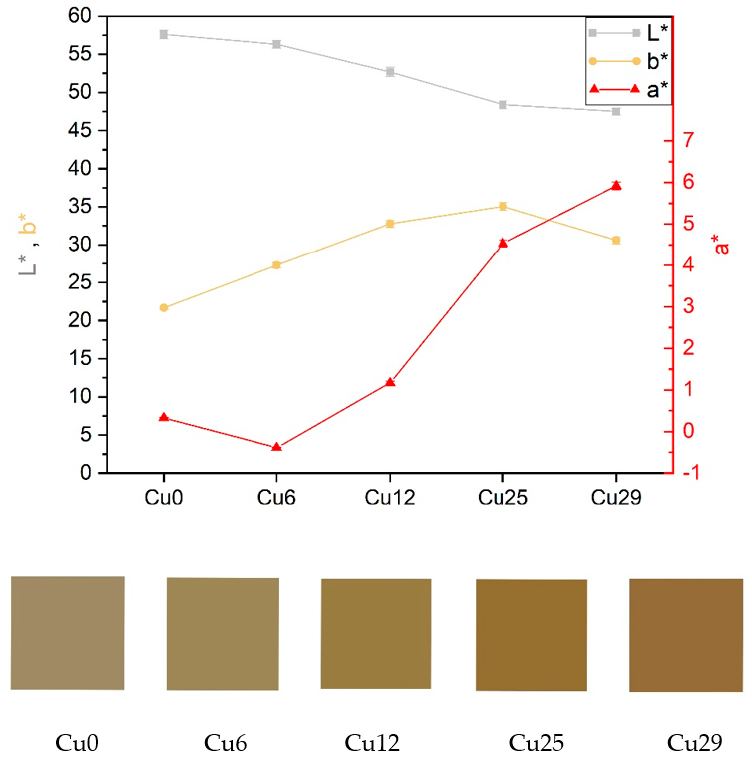
Figure 2. Coloration of the ZrN-Cu coatings in L * a * b * space.